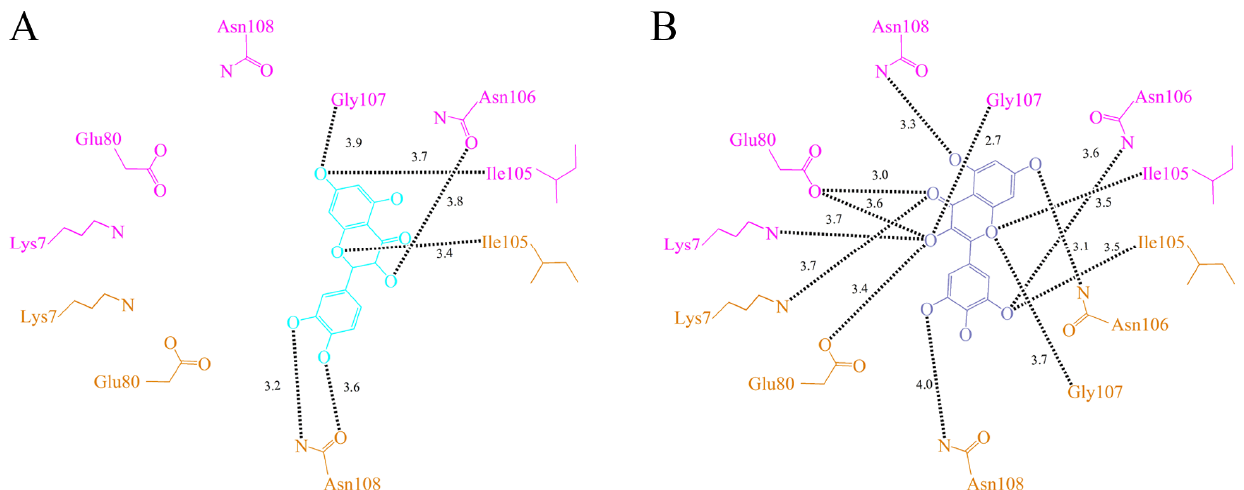
Figure 5. The binding modes. ( A ) Quercetin ‐ binding mode of PaSSB. Residues Ile105, Asn106, Gly107, and Asn108 were involved in quercetin binding (PDB entry 7VUM). Monomers A and C of PaSSB are colored in pink and bright orange, respectively. ( B ) Myricetin ‐ binding mode of PaSSB. Residues Lys7, Glu80, Ile105, Asn106, Gly107, and Asn108 in PaSSB were involved in myricetin binding (PDB entry 5YUN). For comparison, Lys7 and Glu80 in both monomers A and C of PaSSB interacted only with myricetin and not quercetin.